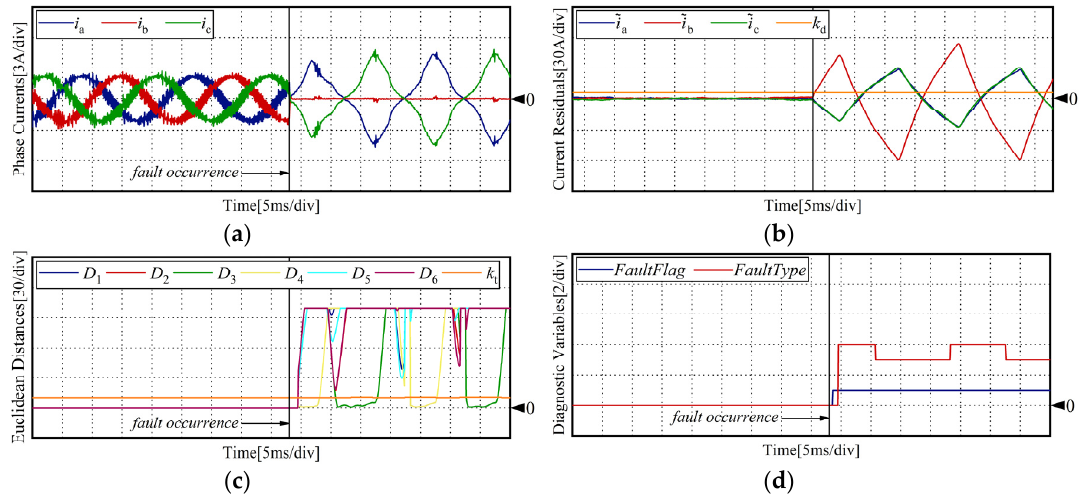
Figure 15. Test for B-phase OC fault at a reference speed of 800 r/min. ( a ) Phase currents. ( b ) Current residuals. ( c ) Euclidean distances. ( d ) Diagnostic variables.